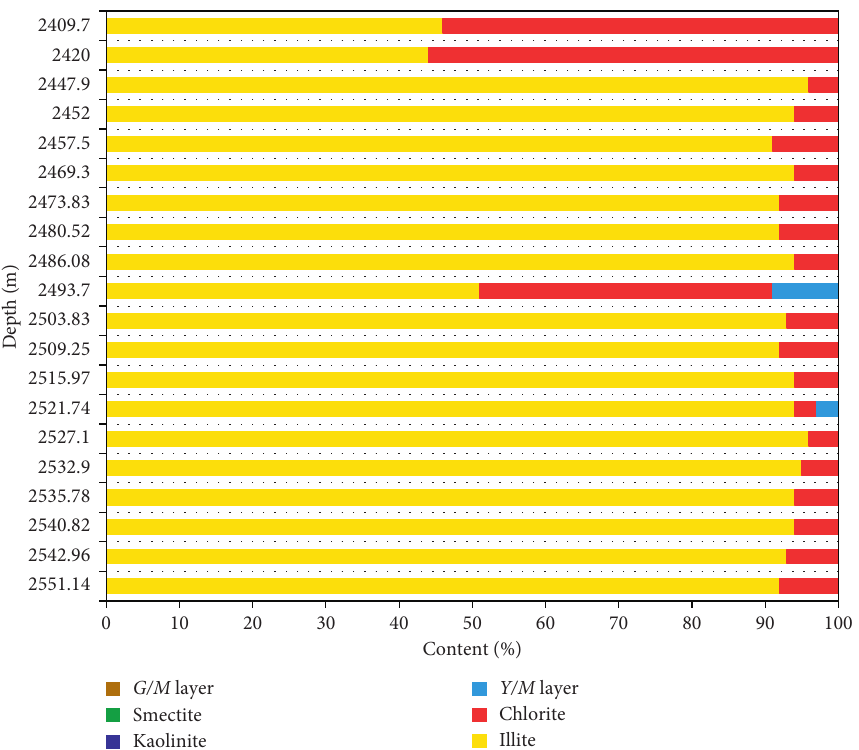
Figure 6: Distribution of clay mineral